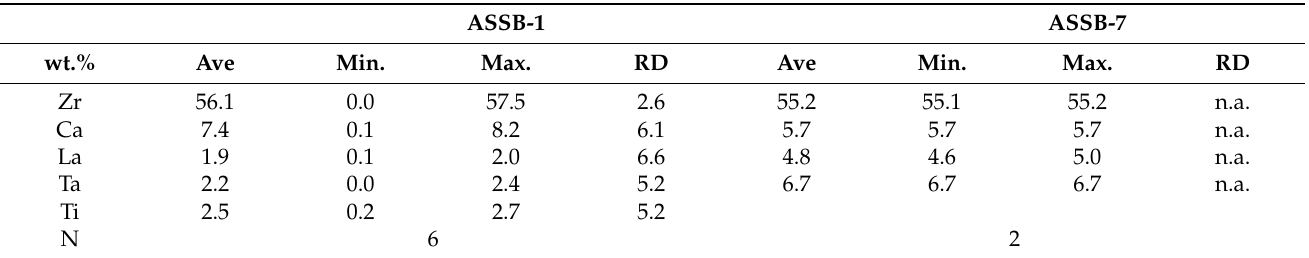
Table A7. Composition of ZrC (wt.%) based on single-point analysis (only in ASSB-1). Ave.: arith- metic average; Min./Max.: lowest/highest measured values; RD: relative standard deviation (%);N: number of measurements. ASSB-1